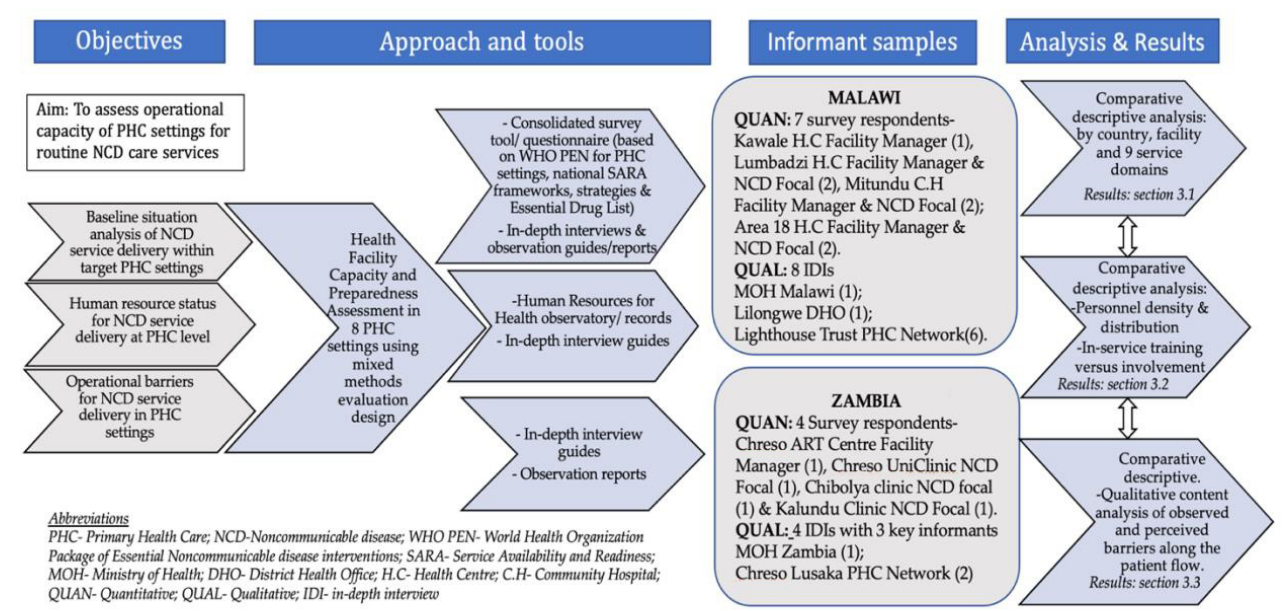
Figure 2. Study theoretical and methodological framework.